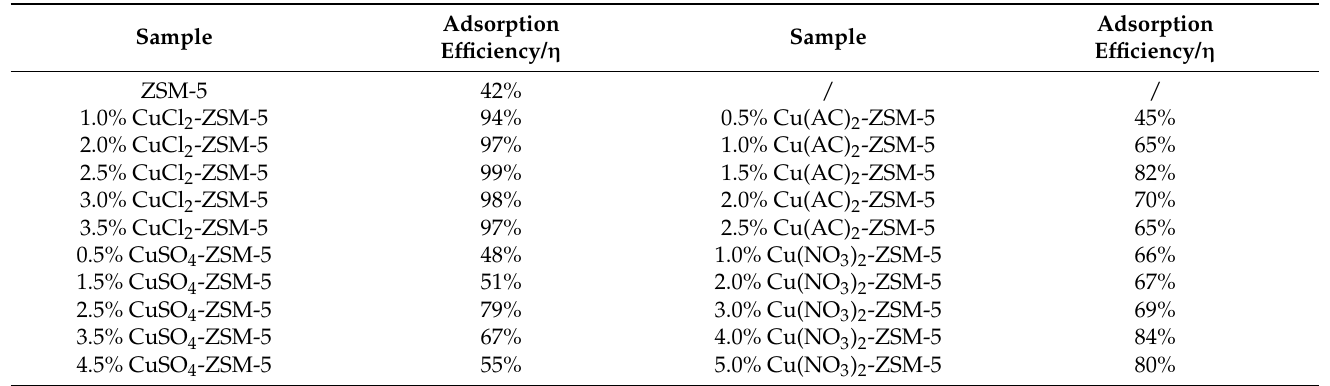
Table 2. Mercury removal efficiency of different Cu-ZSM-5 molecular sieves.